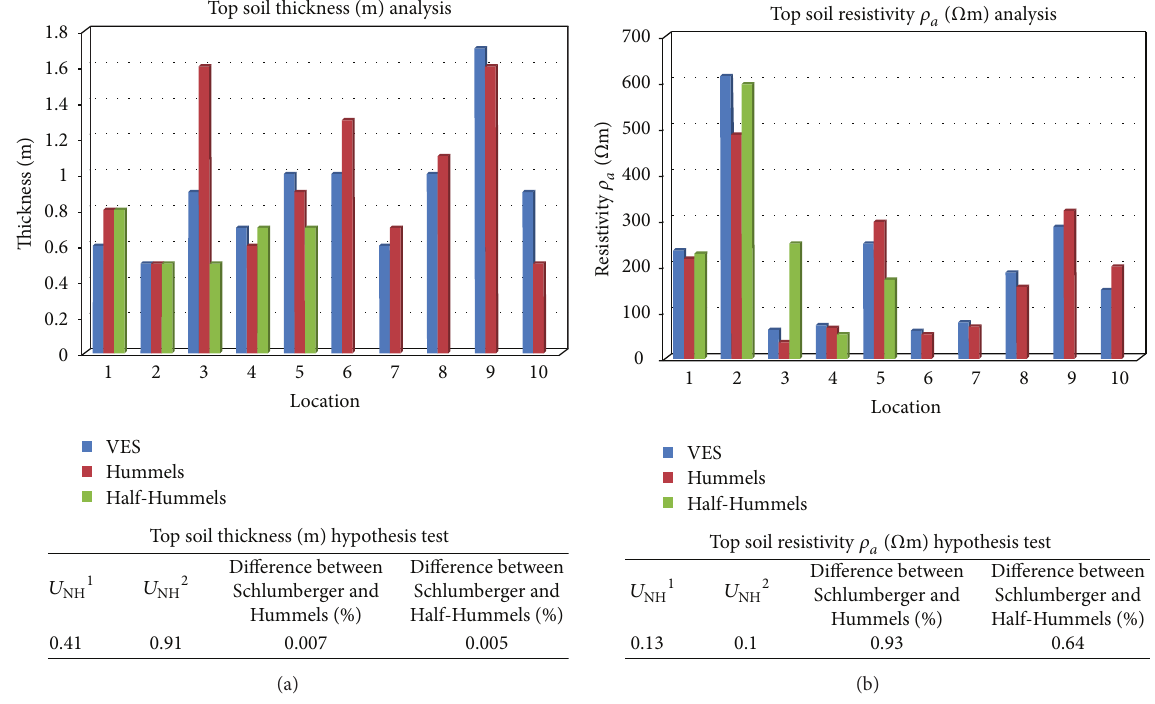
Figure 12: Bar chart and statistical test of hypothesis table for the different array methods comparing (a) topsoil thickness and (b) topsoil resistivity, for stations on banded gneiss.